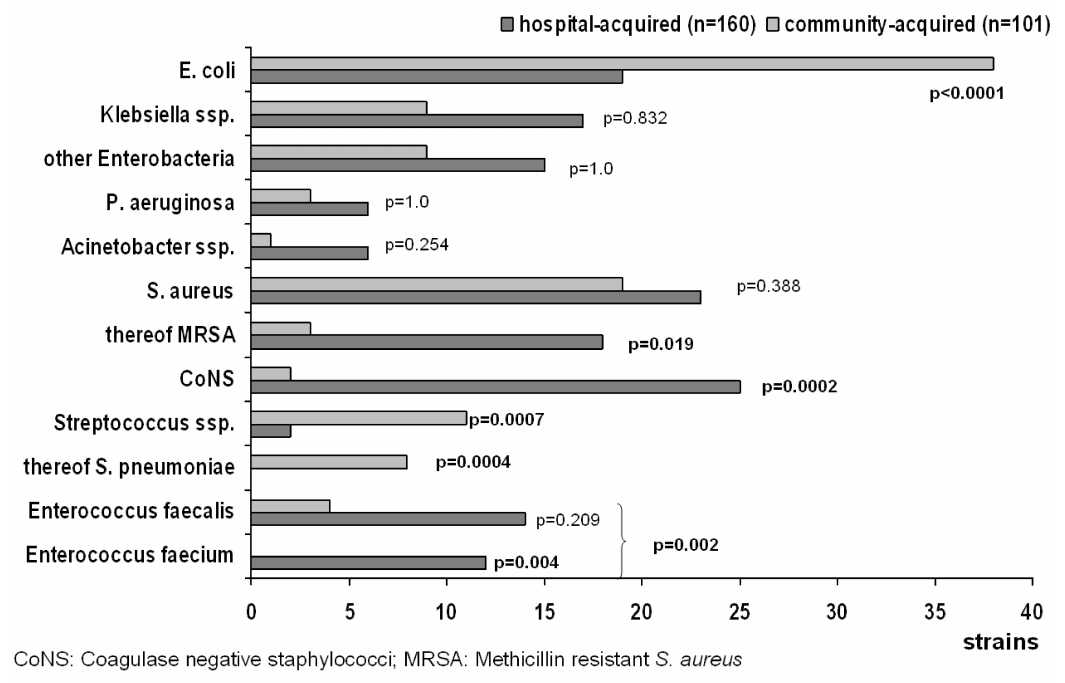
Figure 1: Identified causative agents (N=261) in blood cultures from sepsis patients